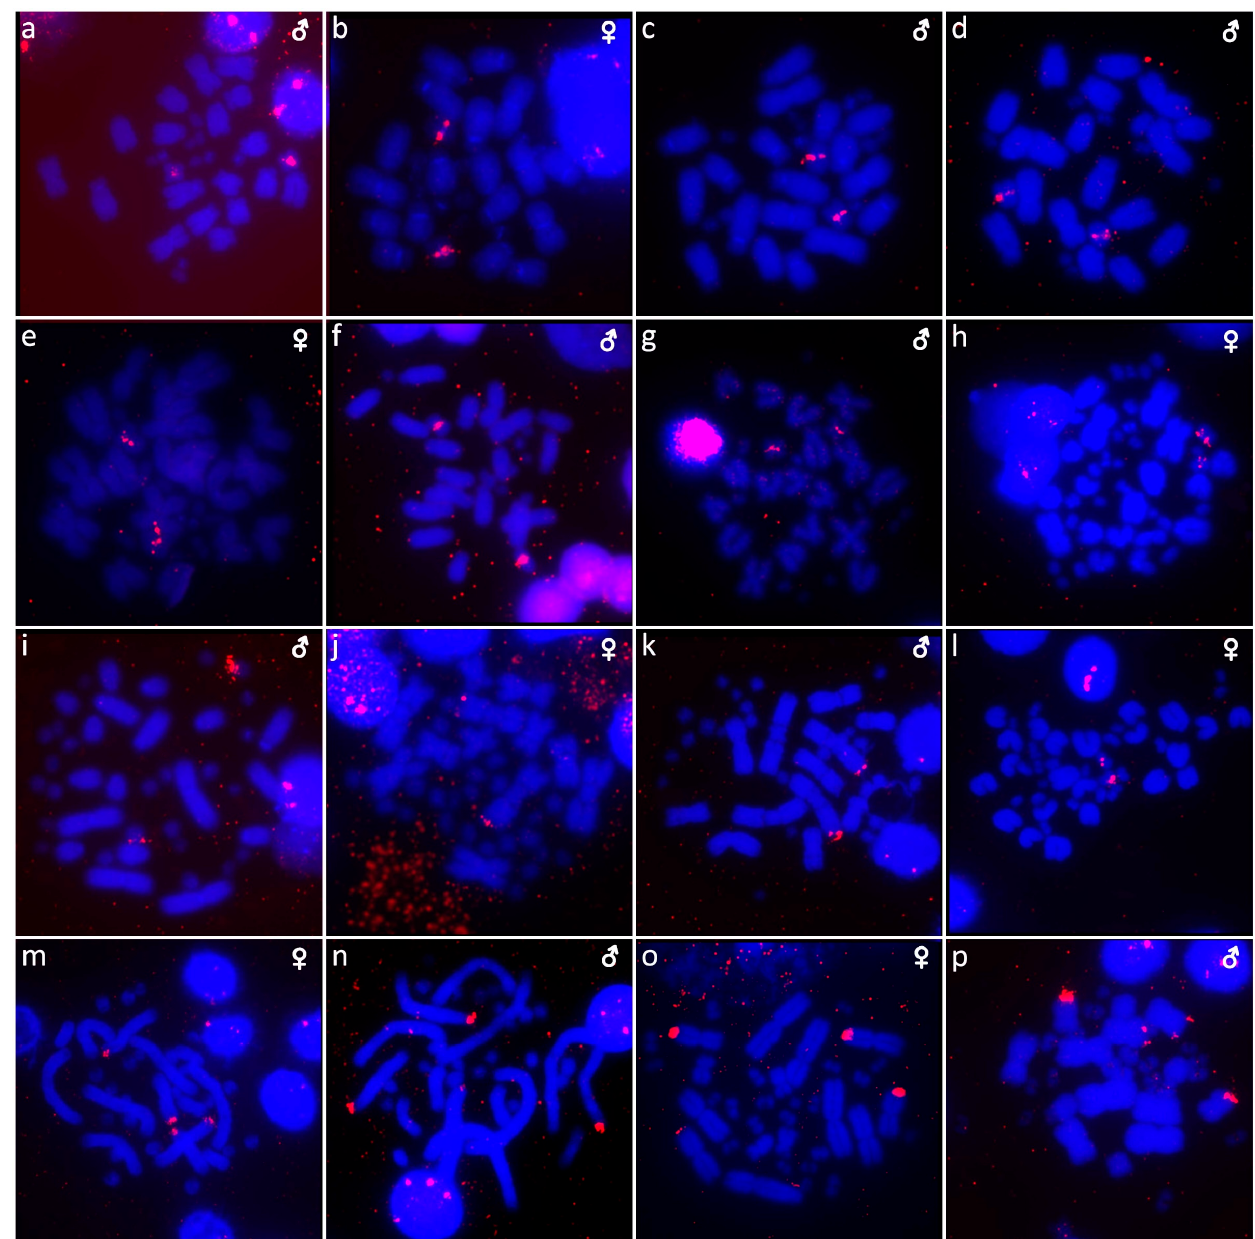
Figure 8. In situ hybridization with probe for 18S/28S rDNA loci in Abronia campbelli ( a ), Abronia deppii ( b , c ), Abronia graminea ( d ), Abronia lythrochila ( e , f ), Abronia mixteca ( g ), Barisia rudicollis ( h , i ), Celestus warreni ( j , k ), Gerrhonotus liocephalus ( l ), Heloderma exasperatum ( m , n ) and Heloderma horridum ( o , p ).